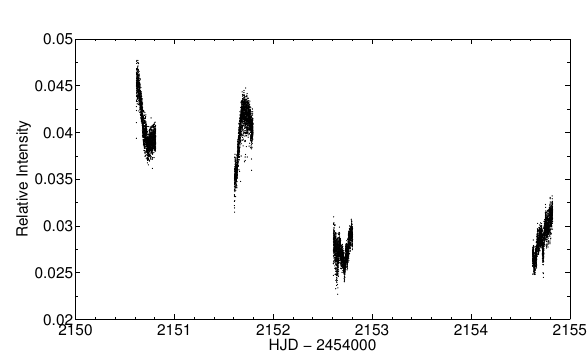
Figure 1: Optical photometry of V1408 Aql on four nights during 10-15 August 2012. Intensity is shown relative to the combined light of stars labeled 6 and 8 of Figure 1 in Bayless et al. (2011). An orbital sine drop in brightness between the second and third